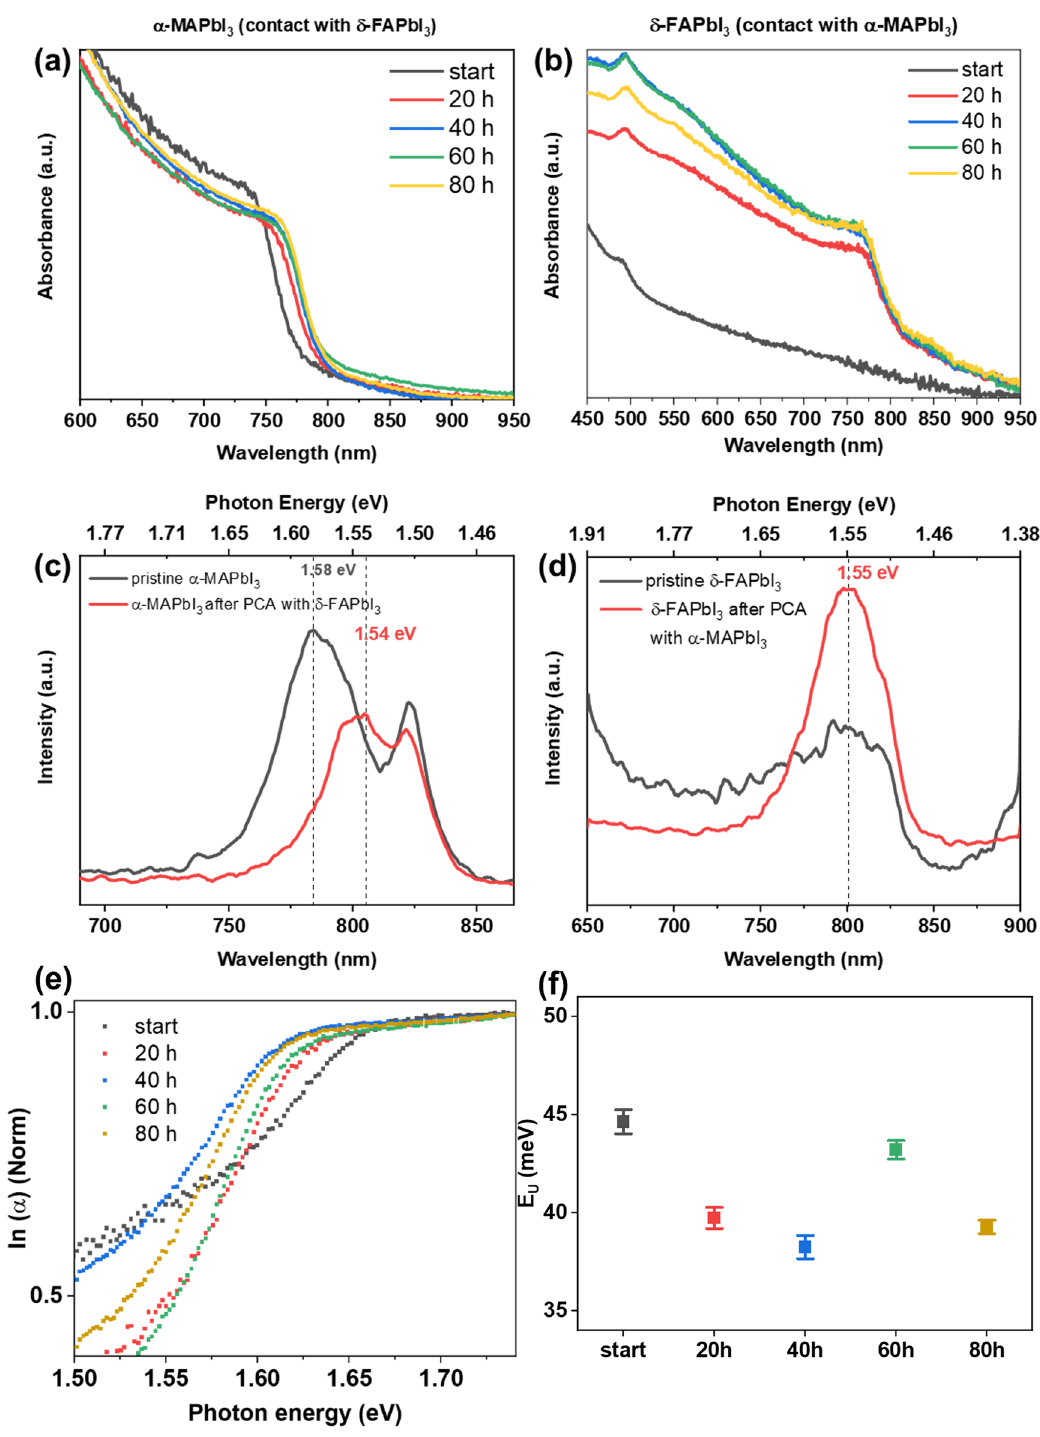
Figure 2. UV–vis spectra of MAPbI 3 ( a ) and FAPbI 3 ( b ) thin films after different times of physical contact annealing (PCA) at 100 °C. PL emission of ( c ) MAPbI 3 before and after 80 h PCA and ( d ) FAPbI 3 before and after 80 h PCA. ( e ) Normalized plots used for the calculation of the estimated Urbach energy. ( f ) Calculated E U